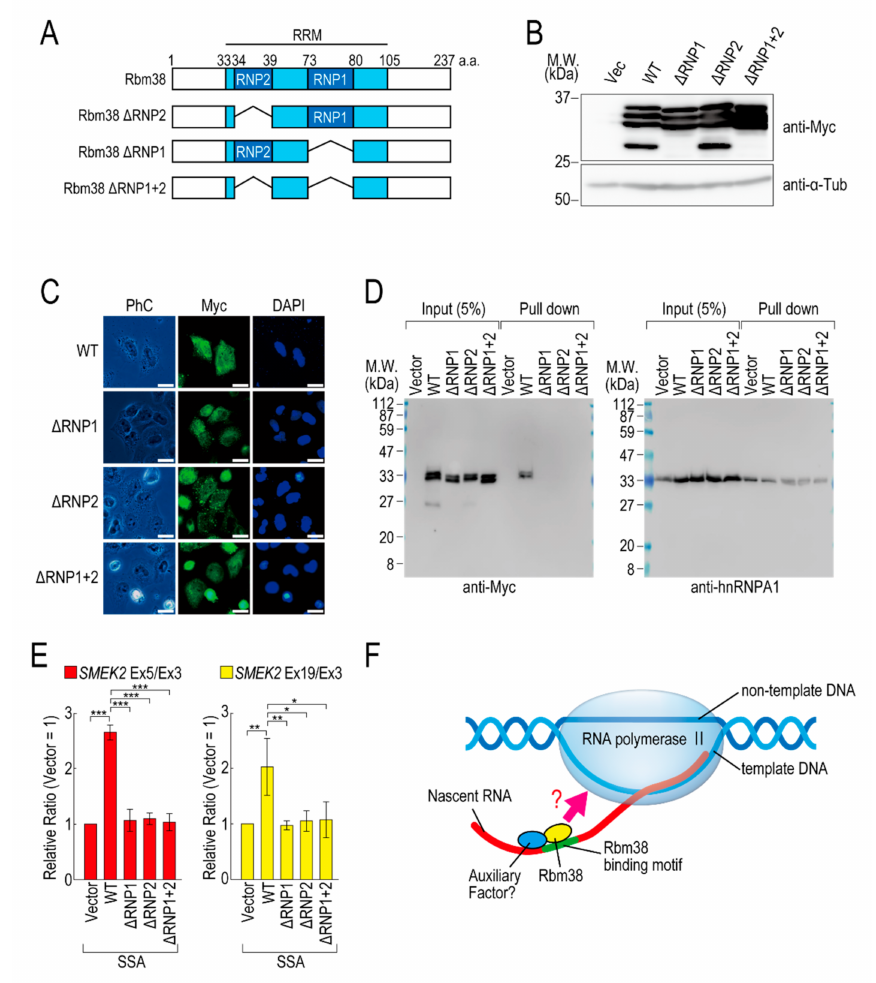
Figure 4. RNA binding motif of Rbm38 is important for suppressing the transcription elongation defect. ( A ) A schematic of the structure of the deleted RNA binding proteins. ( B , C ) HeLa cells were